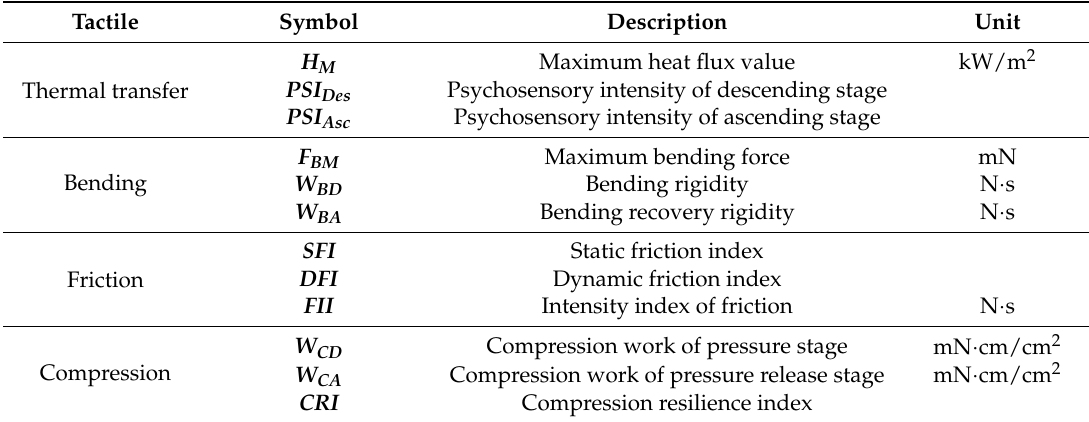
Table 1. Indices definition for objective evaluation of tactile